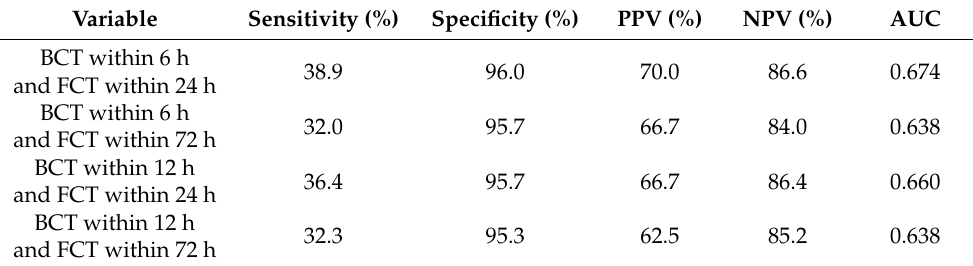
Table 7. Sensitivity, specificity, positive predictive value, negative predictive value, and area under the curve of hematoma heterogeneity to predict hematoma expansion in different